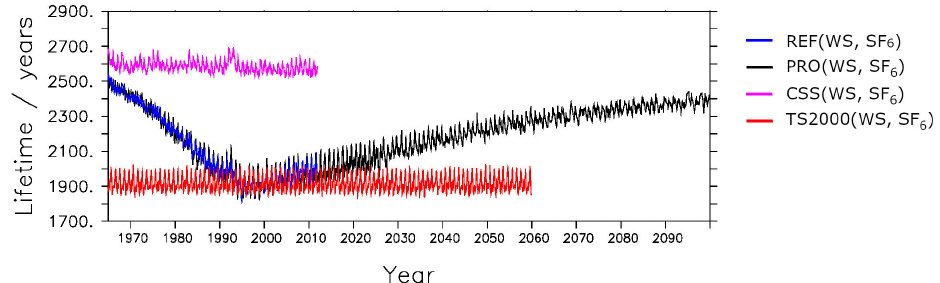
Figure 2. Global stratospheric and mesospheric lifetimes of SF 6 calculated from the tracer with realistic lower boundary conditions and SF 6 sinks ( tr (WS, SF 6 )). Blue represents the reference simulation (REF), black represents the projection simulation (PRO), pink represents the constant reactant species simulation (CSS), and red represents the time slice 2000 simulation